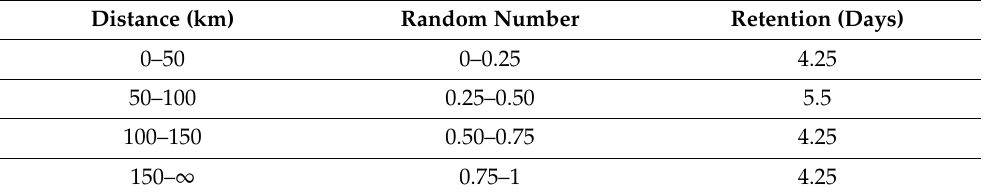
Table 14. Simulation of container retention according to the distance to the container’s final destination.